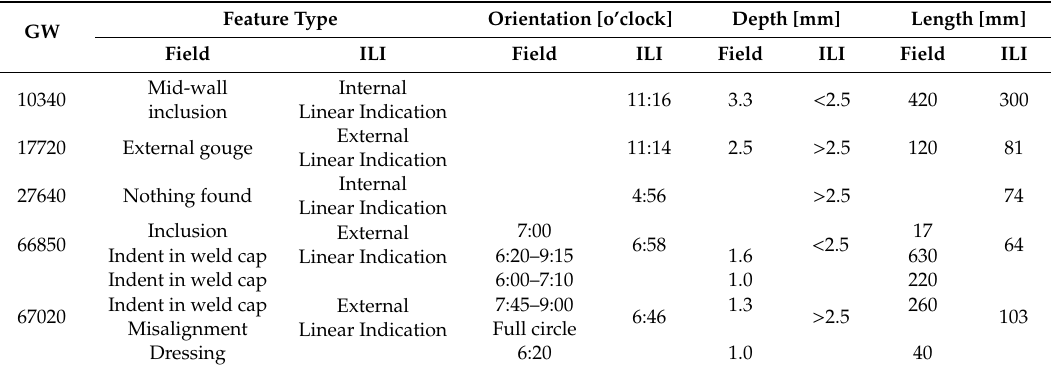
Table 7. Excavation results of the second five digs.